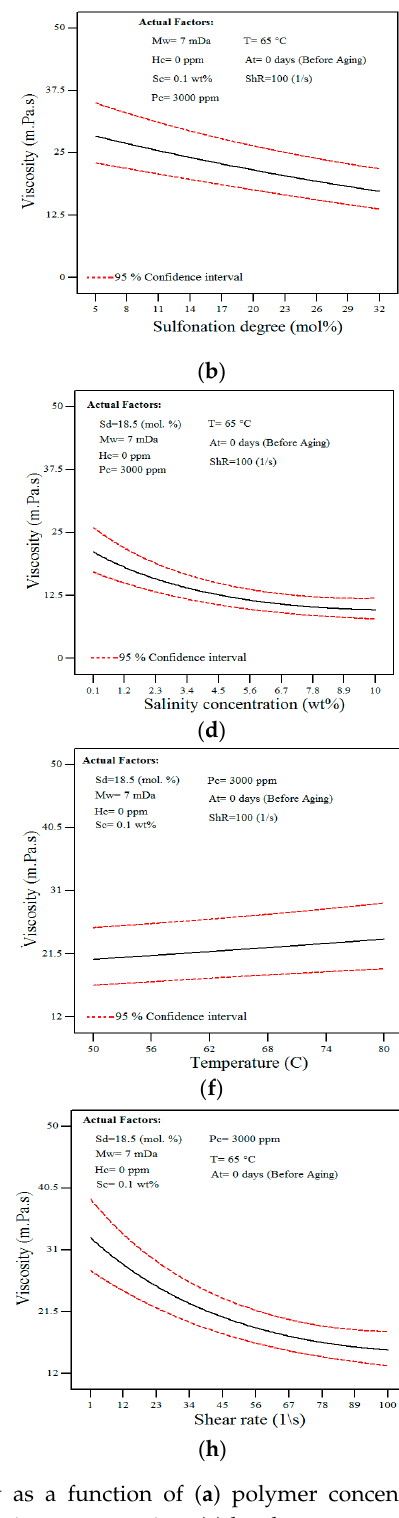
Figure 7. Different regimes based on polymer concentration ( C ) and overlap concentration ( C* ). Figure 6b, shows that a decrease in the apparent solution viscosity is observed with increasing levels of the sulfonation degree. This may be because, in the presence of salt, the intra-molecular repulsion between negative charges of the sulfonated groups is minimized due to the shielding effect of counter ions (Na + ) from the salt. As reported earlier [55], the reduction in the intra-molecular repulsion had therefore magnified the interaction between the hydrophobic groups (such as CH 3 ) that were located along with the hydrophilic groups (AMPS) (Figure 8) in yielding a coil-like configuration. Since a higher level of sulfonation degree will result in a higher number of hydrophobic groups (CH 3 ), there is, therefore, a greater chance of the intra-molecular association occurring, hence resulting in the reduction of the polymer hydrodynamic size and consequently, the reduced viscosity level. Figure 8. Hydrophobic groups association mechanism.